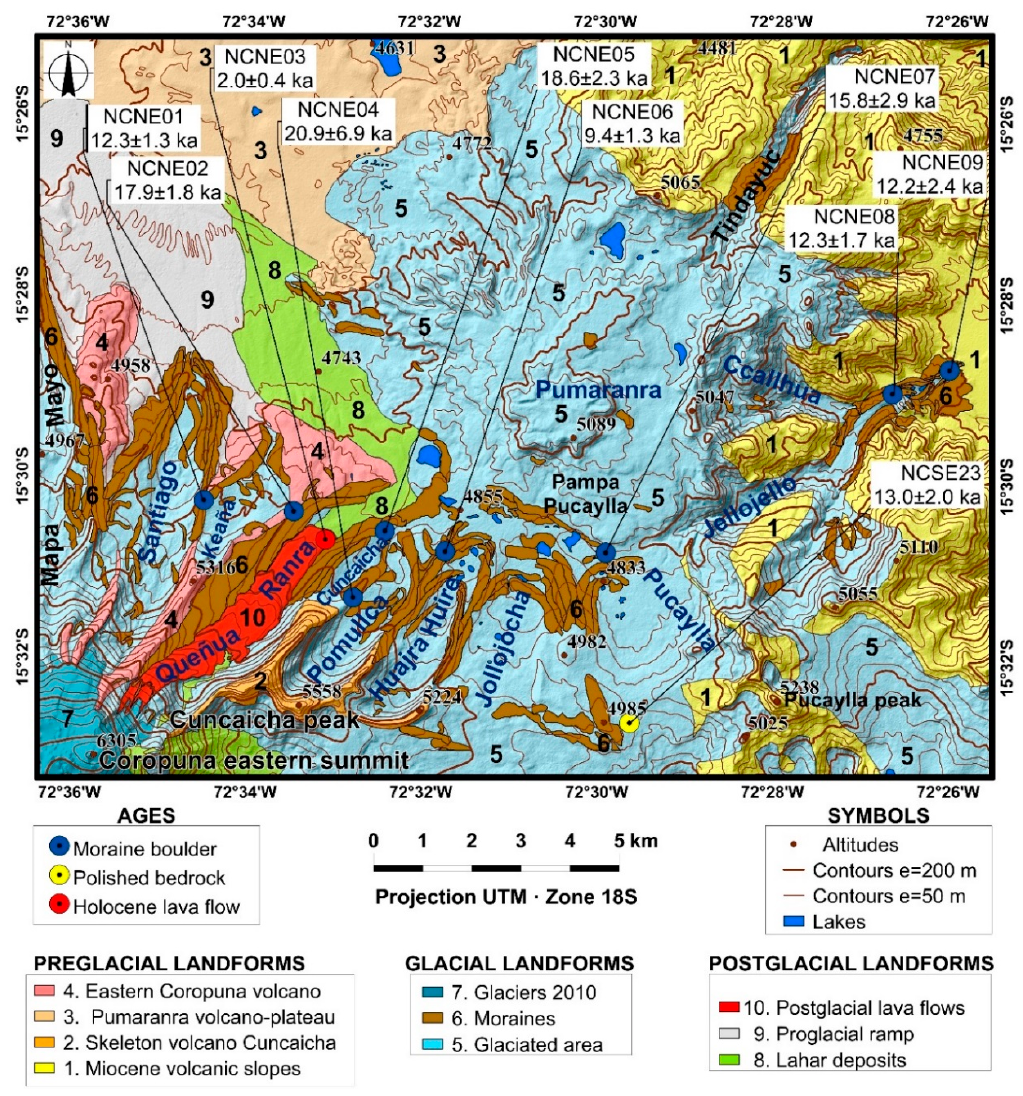
Figure 4. Geomorphological map.